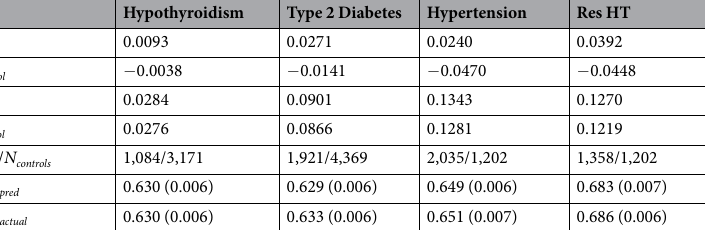
Table 5. Mean and standard deviation for PGS distributions for cases and controls, using predictors built from SNPs only and trained on case-control status alone. Predicted AUC from assumption of displaced normal distributions and actual AUC are also given.